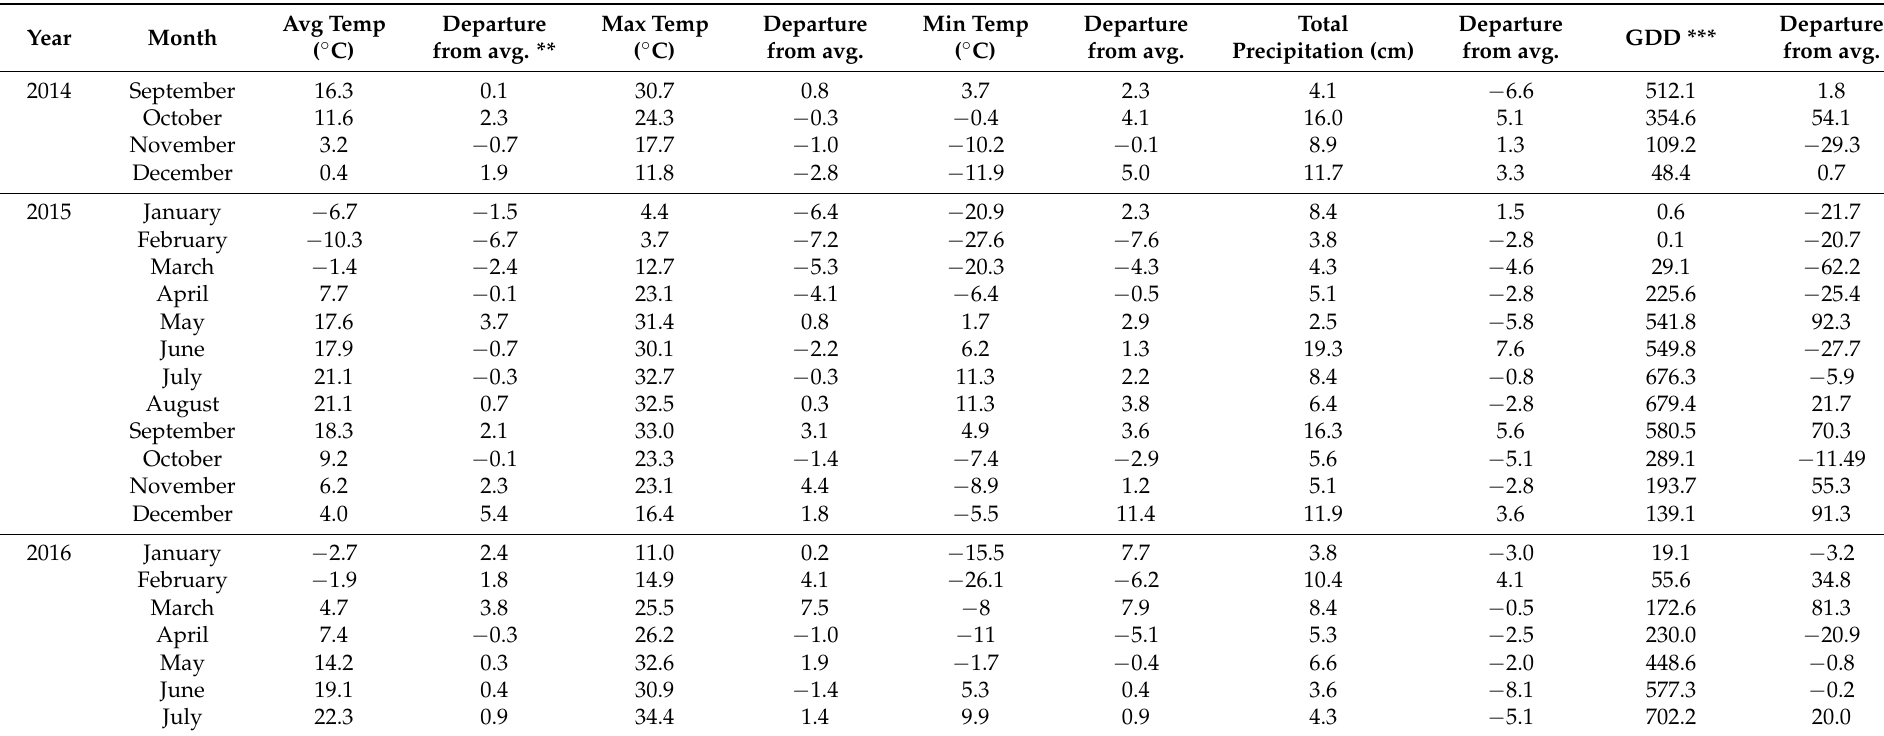
Table 1. Weather Data for the Date of Planting and Nitrogen Trial for the University of Massachusetts Agricultural Research Farm, South Deerfield, MA